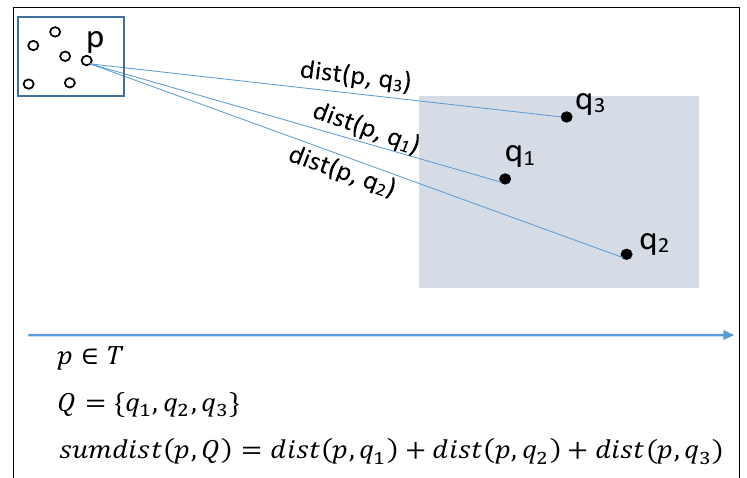
Figure 10. Brute-force.